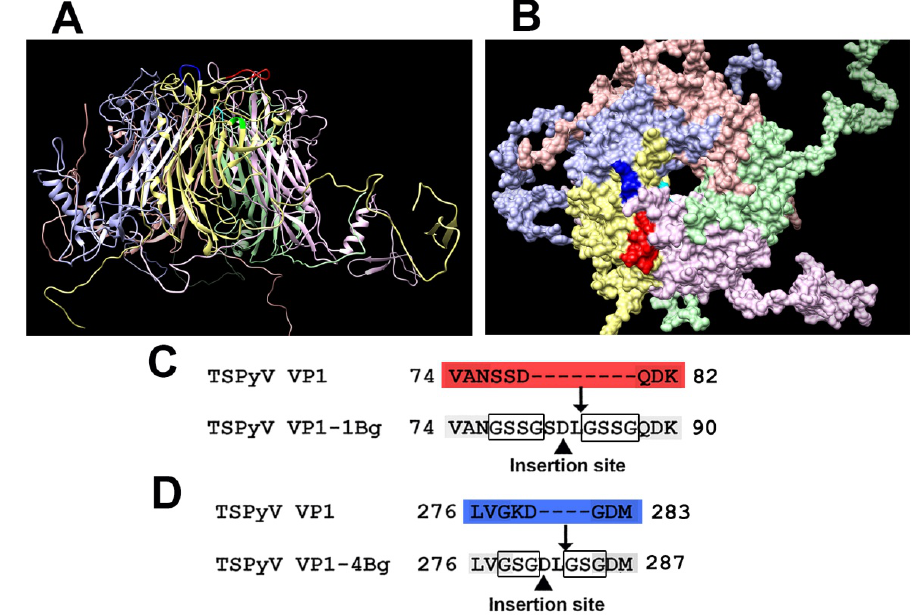
Figure 1. Molecular model of TSPyV VP1 pentamer and modification scheme of two surface-exposed loops: site #1 (aa 74–82) and site #4 (aa 276–283). The predicted structure of TSPyV VP1 pentamer is shown from the side ( A ) and the front ( B ); ( C ) modification scheme of site #1; ( D ) modification scheme of site #4. The site #1 is shown in red and the site #4 is shown in blue.